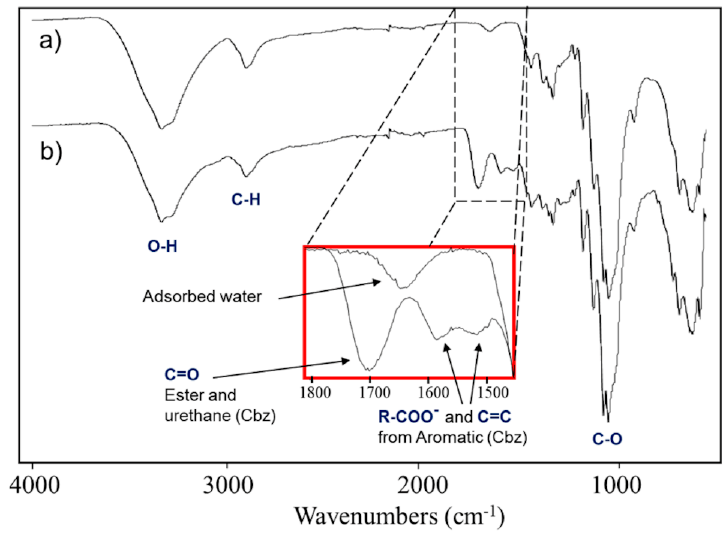
Figure 2. FTIR spectra of: ( a ) cellulose sample and ( b ) cellulose modified with N-carbobenzyloxy-L- aspartic anhydride (Cel-Asp-N-Cbz).